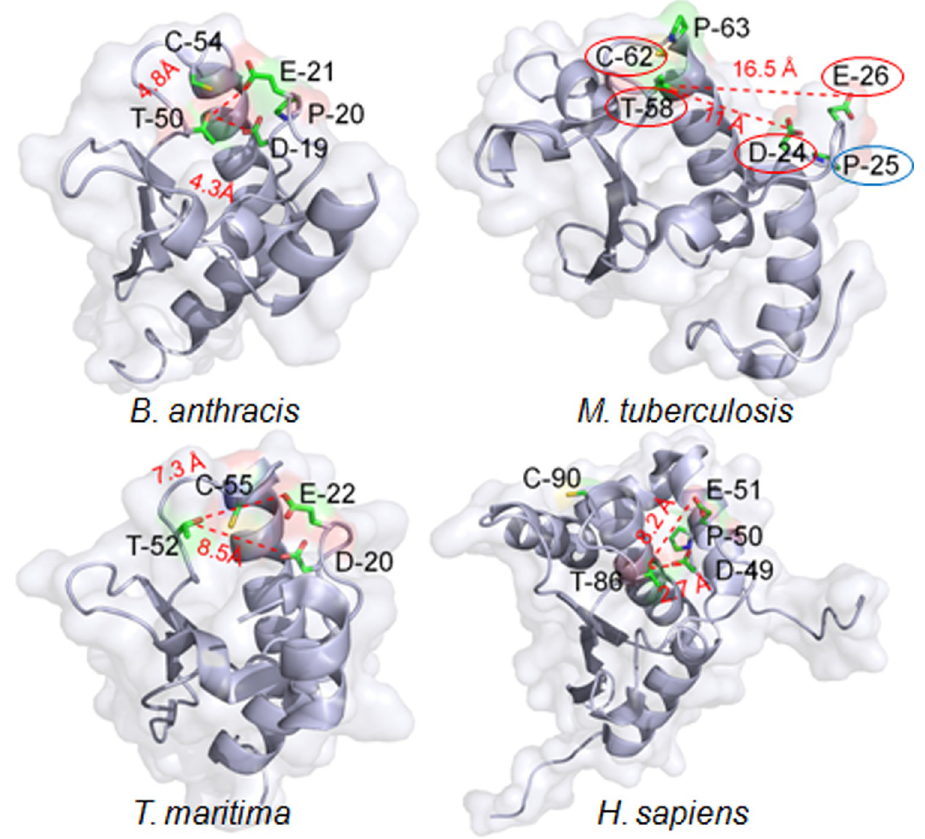
Fig 1. Three-dimensional structure of Rv1466 (SufT). Mtb SufT like other DUF59 proteins contains a small surface of conserved homology. Ribbon diagrams are shown for the Bacillus anthracis YitW (PDB ID: 3LNO); Mtb SufT (PDB ID: 5IRD); Thermotoga maritima TM0487 (PDB ID: 1UWD); and Homo sapiens FAM96a (PDB ID: 2M5H). The side chains of the conserved D, E, T, and C (red encircled) residues are highlighted. Oxygen, sulfur, and nitrogen atoms are represented with red, yellow, and blue color, respectively. Distance in Angstrom ( Å ) is represented between the side- chain hydroxyl of the T, D, and E residues. A proline (P25 in Mtb ) present in the motif as DPE (blue encircled) and the consecutive proline (P63 in Mtb ) next to the C residue are represented in the Mtb SufT structure.